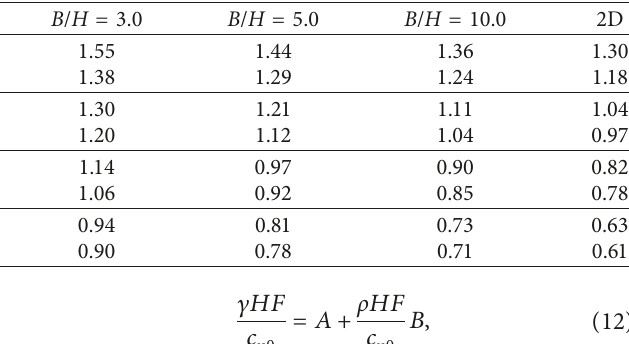
Table 4: Factors of safety for the example